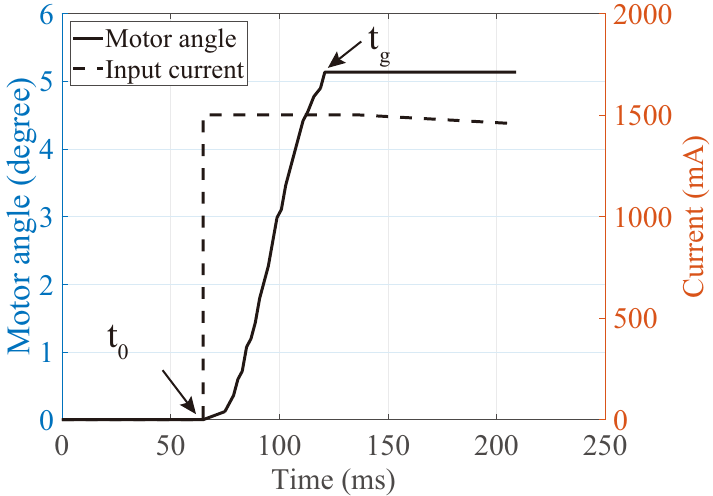
Figure 5. Angle of the motor during the grasping motion. The grasping was conducted without corneal tissue. The grasping time for full-grasp was 56 ms. With the corneal tissue, the grasping time is always shorter than 56 ms because the cornea’s thickness reduces the maximum grasping angle.